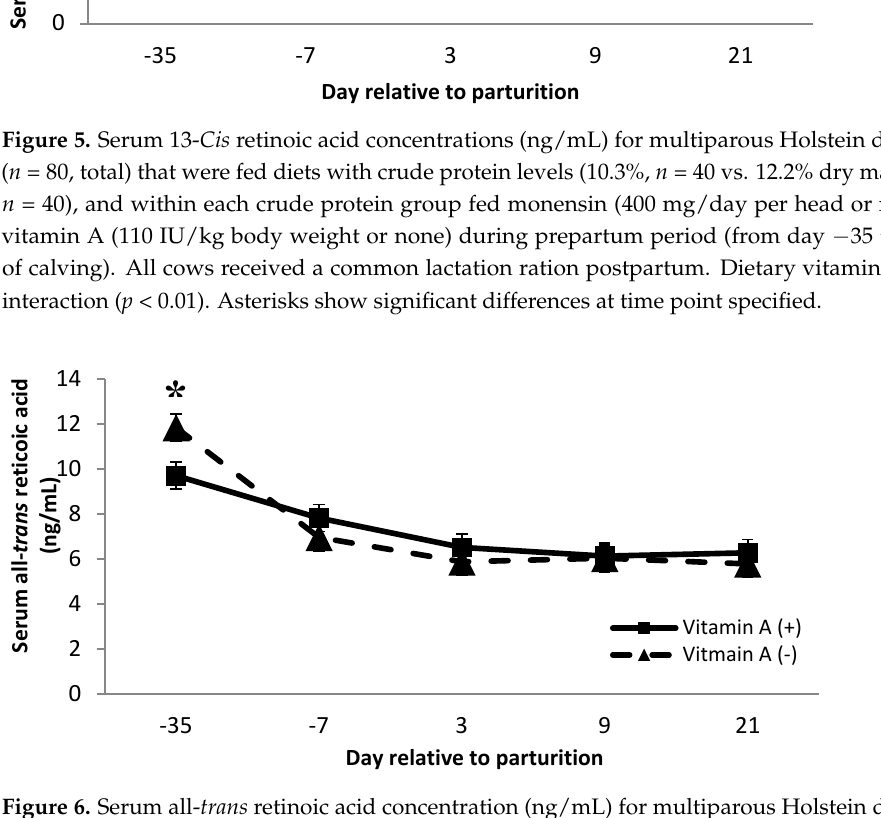
Figure 6. Serum all- trans retinoic acid concentration (ng/mL) for multiparous Holstein dairy cows ( n = 80, total) that were fed diets with crude protein levels (10.3%, n = 40 vs. 12.2% dry matter basis, n = 40), and within each crude protein group fed monensin (400 mg/day per head or none) and vitamin A (110 IU/kg body weight or none) during prepartum period (from day − 35 to the day of calving). All cows received a common lactation ration postpartum. Dietary vitamin A × time interaction ( p = 0.005) ( p < 0.01). Asterisks show significant differences at time point specified.